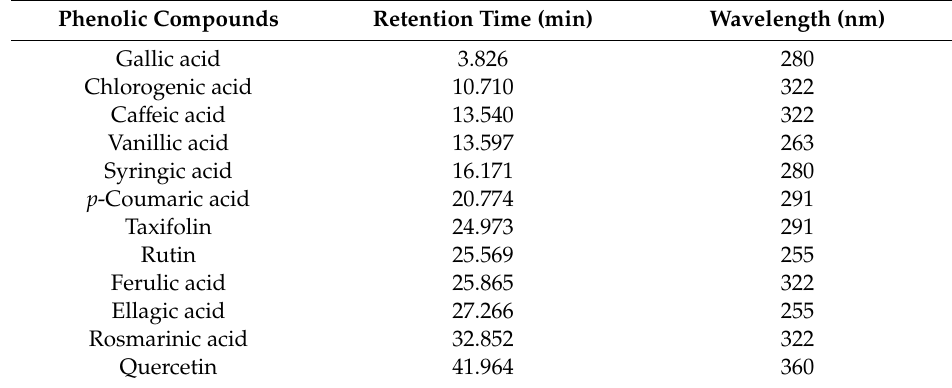
Table 11. Chromatographic conditions (retention time and wavelength) of the selected phenolic